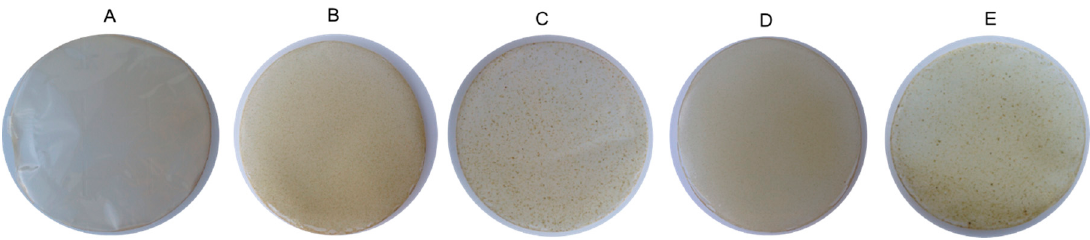
Figure 1. Pictures of the films: ( A ) control (Pectin) (Ctrl), ( B ) Copena F1 without fibre (Copwtf), ( C ) Copena F1 with fibre (Copwf), ( D ) Villanueva without fibre (Viwtf) and ( E ) Villanueva with fibre (Viwf).